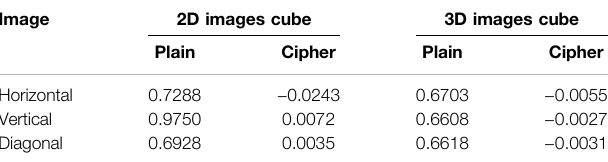
TABLE 3 | Correlation coef fi cient of the plain images and cipher images. TABLE 4 |